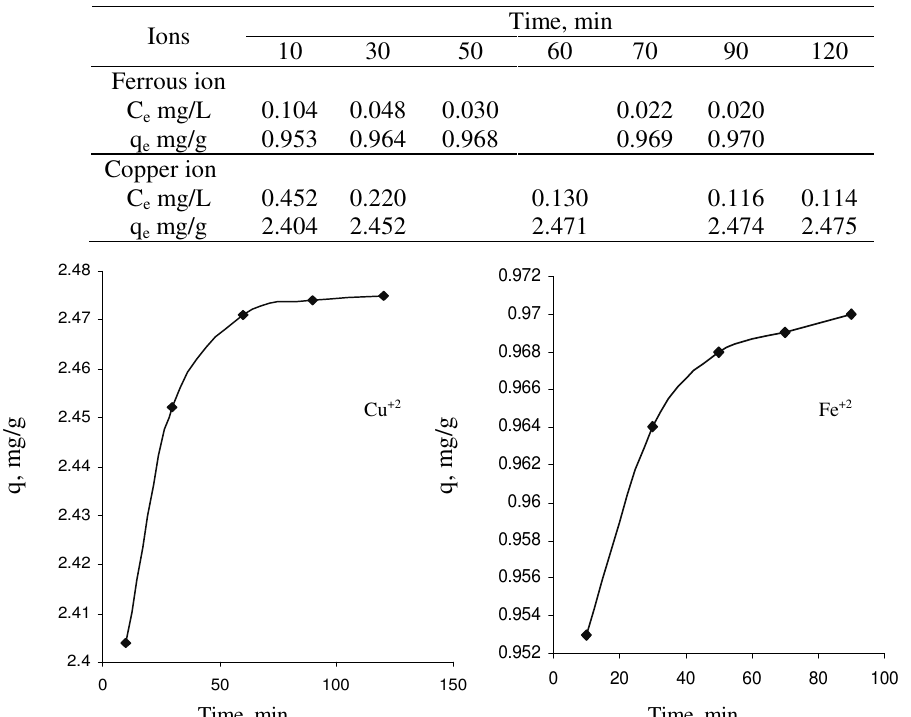
Table 2. Equilibrium parameters for the adsorption of metal ions onto pine fruit powder at different time interval.